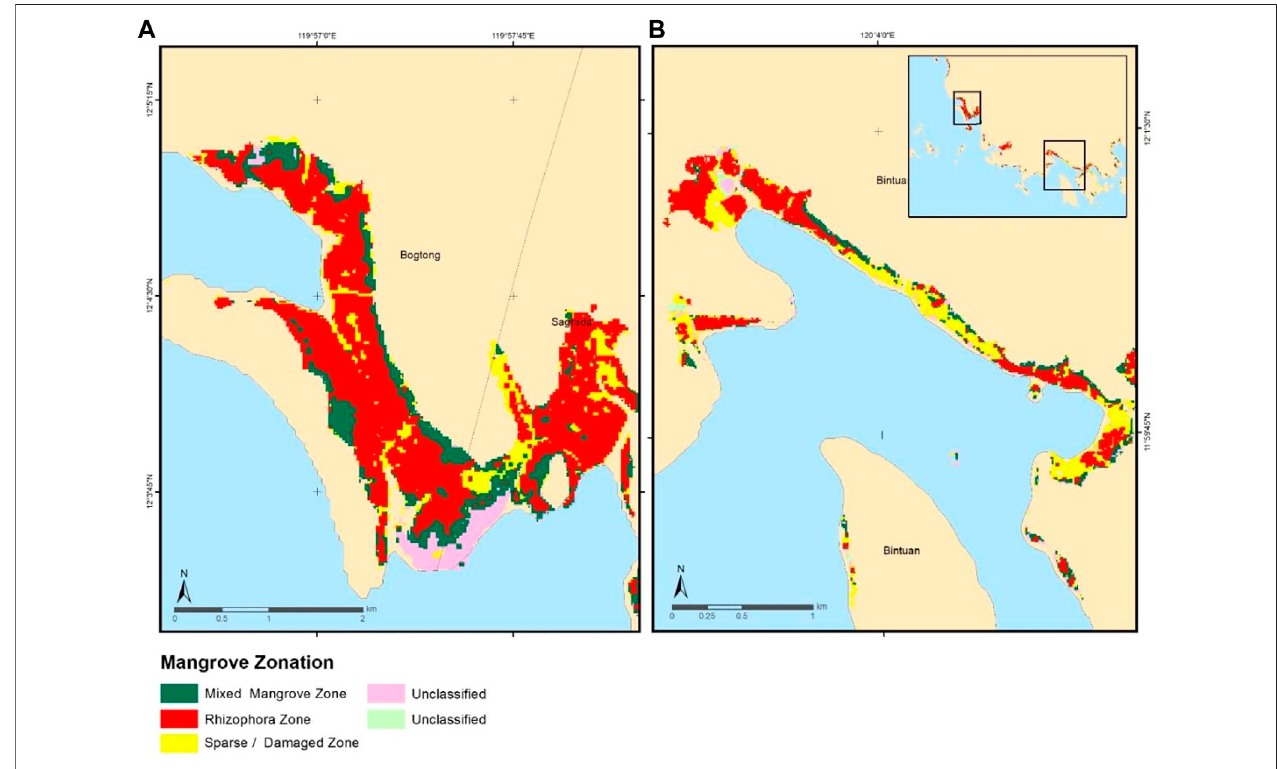
FIGURE4| GeneratedmangrovezonationinCoron (A) andBusuanga (B) withthecorrespondingclassesidenti fi ed.Bothsitesweredominatedbythe Rhizophora zone, consist of Rhizophora species.